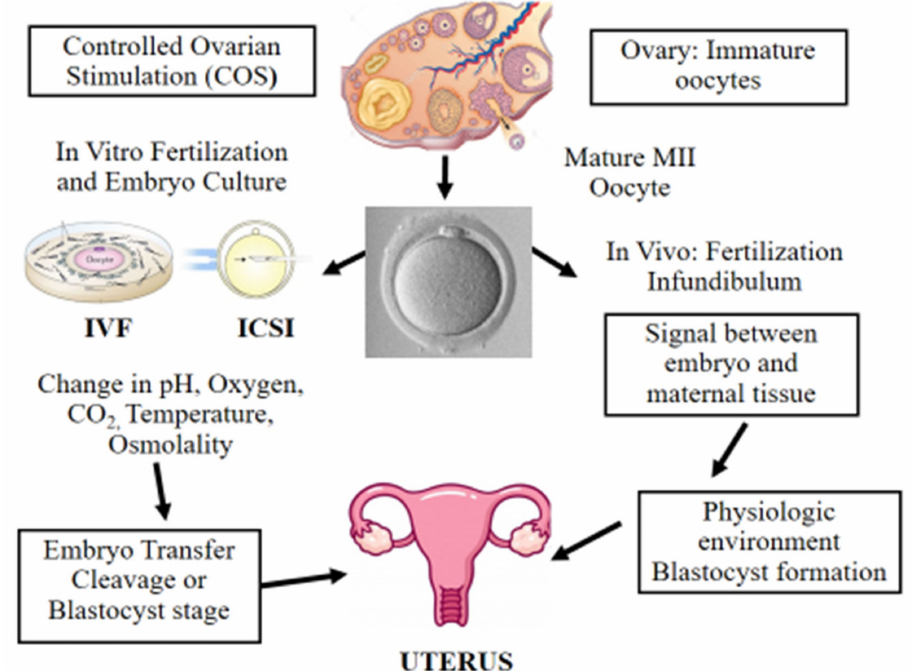
Figure 1. Scheme illustrating in vitro and in vivo fertilization. Controlled ovarian stimulation (COS) is used to promote follicle growth, maturation, and ovulation. ART adopts either IVF or ICSI for fertilization. Following fertilization, the preimplantation embryo is cultured in incubators, where suboptimal culture conditions such as pH, oxygen, temperature, and osmolality may affect its further development. Finally, the in vitro-produced embryo is transferred to the uterus at the cleavage or blastocyst stage. On the other hand, in vivo the female and male gametes interact together and the sperm fertilizes the oocyte in the infundibulum. Next, the developing embryo moves towards the uterus interacting with the female reproductive system in a physiologic and optimal